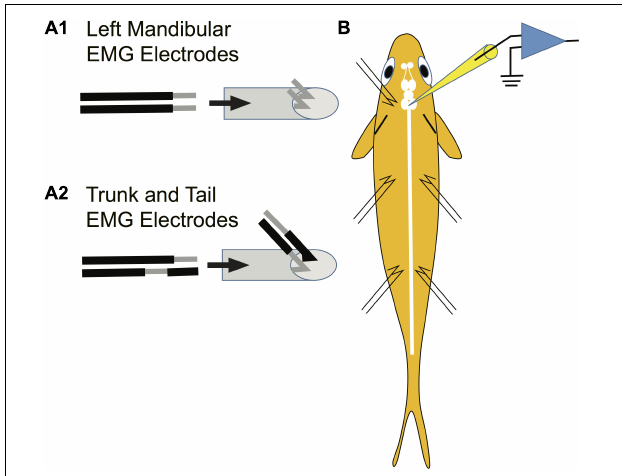
FIGURE 3 | Method used to prepare EMG electrodes. Paired stainless-steel wires were used to record from the mandibular, trunk and tail musculature. (A1) Construction of electrodes used in recording EMGs from the left mandibular muscle. Two mm of insulation was scraped off each electrode tip for mandibular electrodes as shown to the left of the arrow. The pair of wires was drawn through a syringe needle as shown to the right of the arrow so that the tips of the wires protruded 2 mm beyond the tip of the syringe and the tips were then bent at a 45 ◦ angle relative to the syringe needle and were spread apart. This design risked short circuiting the wires but was required due to the small size of the muscle. (A2) The paired electrodes for recording trunk and tail EMGs were constructed differently than those in panel (A1) to minimize the possibility of an electrical short circuit between wires (see section “Materials and Methods”). (B) Placement of EMG electrodes into the left mandibular muscle and bilaterally into the trunk and tail